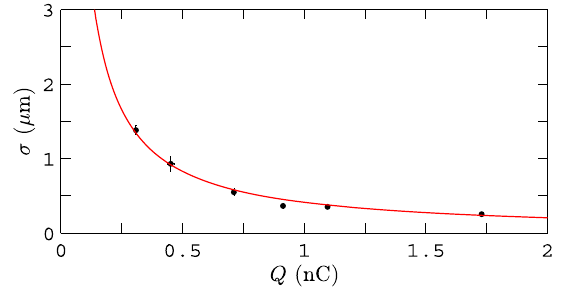
FIG. 22. Position resolution vs beam charge; the red line shows a fit of the function σ ¼ p=Q , where p is a parameter. Note that for this data set the raw stripline signals were attenuated by 6 dB in order to handle the very large signal levels at the higher charge settings, which would otherwise saturate the mixer.